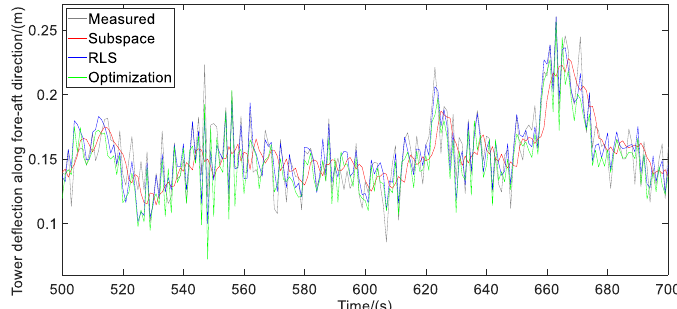
Figure 15. Comparison of tower deflection under scenario Type 4.